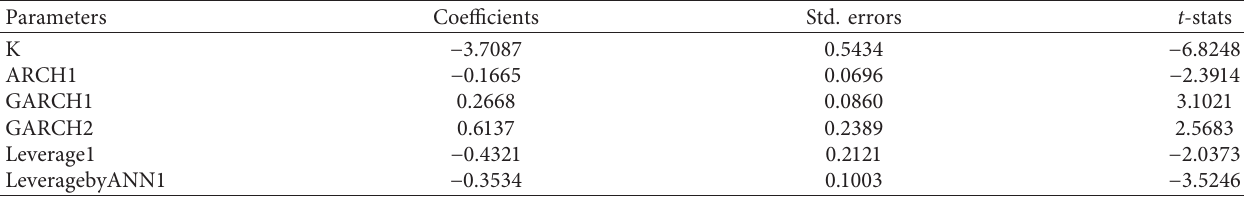
Table 4: The EGARCH-ANN (1, 2, 3, 1) model fitted to the given data.